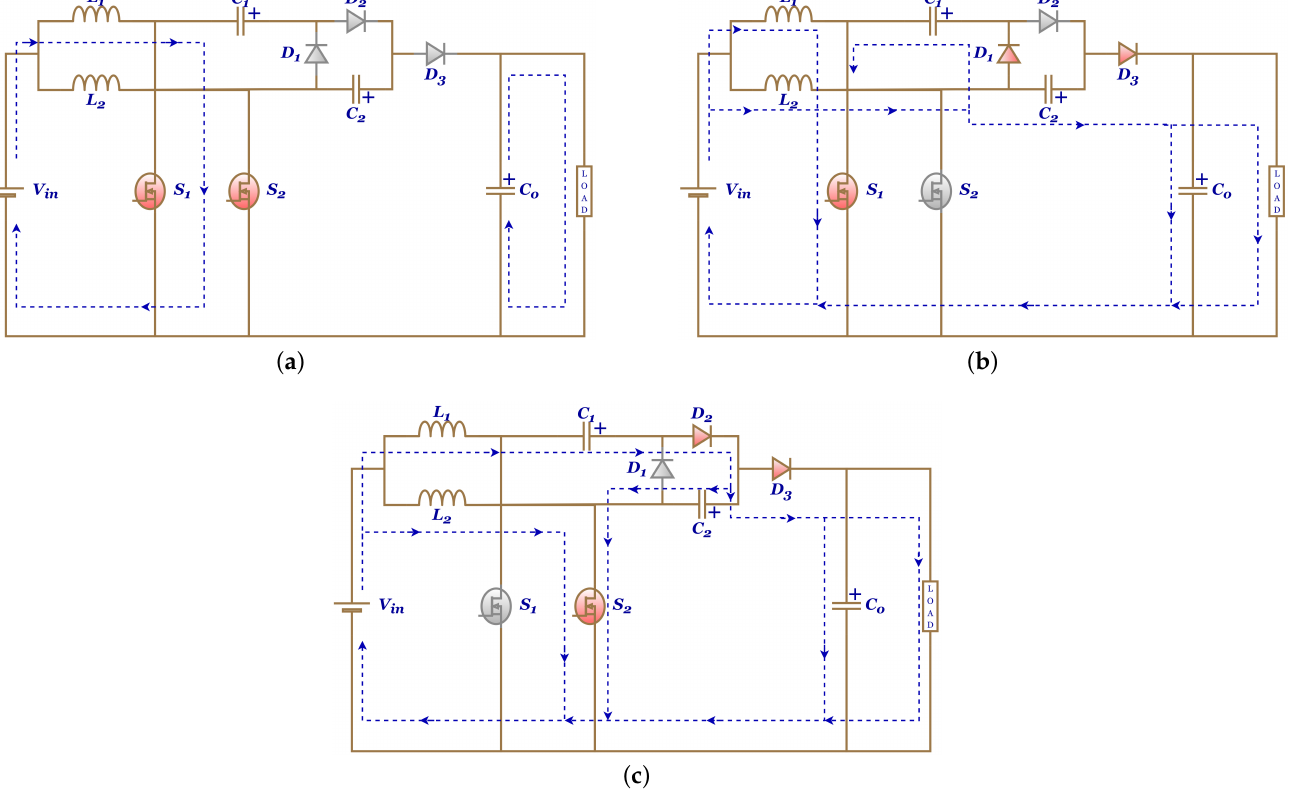
Figure 14. 2nd M-IBC operation: ( a ) S 1 and S 2 , ( b ) S 1 closed, and ( c ) S 2